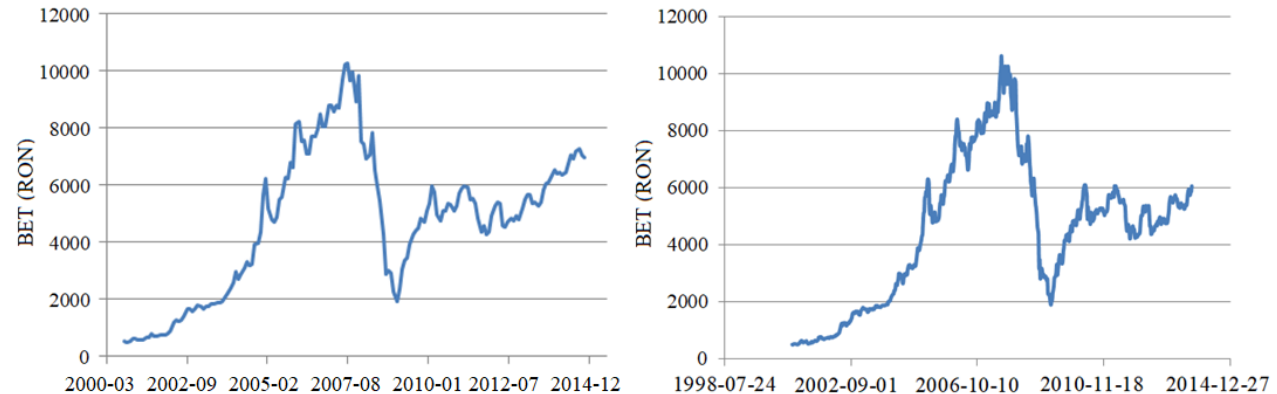
Figure 1. BET monthly ( left-hand side ) and weekly series ( right-hand side ). BET, the first index developed by BSE, is a free-float weighted capitalization index with ten constituents being the reference index for BSE. BET reflects the performance of the most traded Romanian companies, listed at BVB, meeting the highest standards in the fields of investor relations and corporate governance. Constituents’ weights are capped quarterly to ensure that they fulfill the standards for portfolio diversification